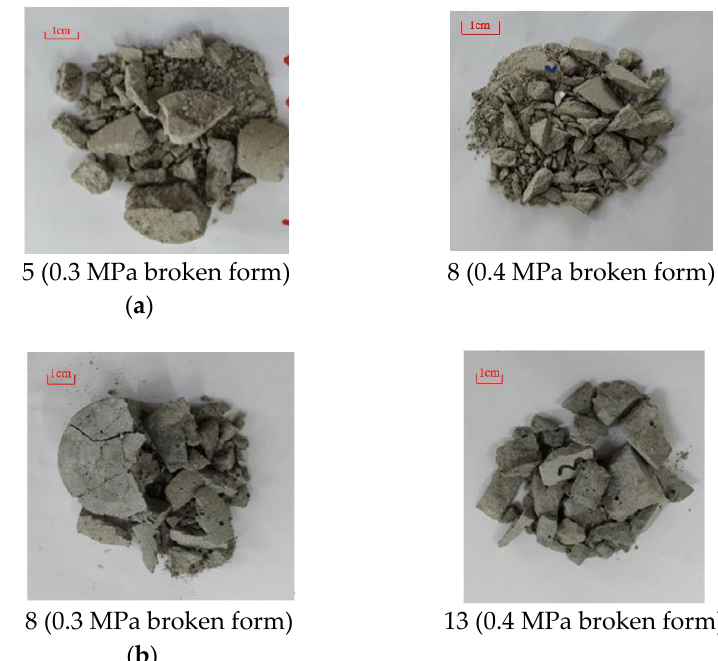
Figure 9. Fracture morphology of specimens with different impact pressures. ( a ) Macroscopic impact crushing of mudstone-like materials. ( b ) Macroscopic impact crushing of sandstone-like materials.